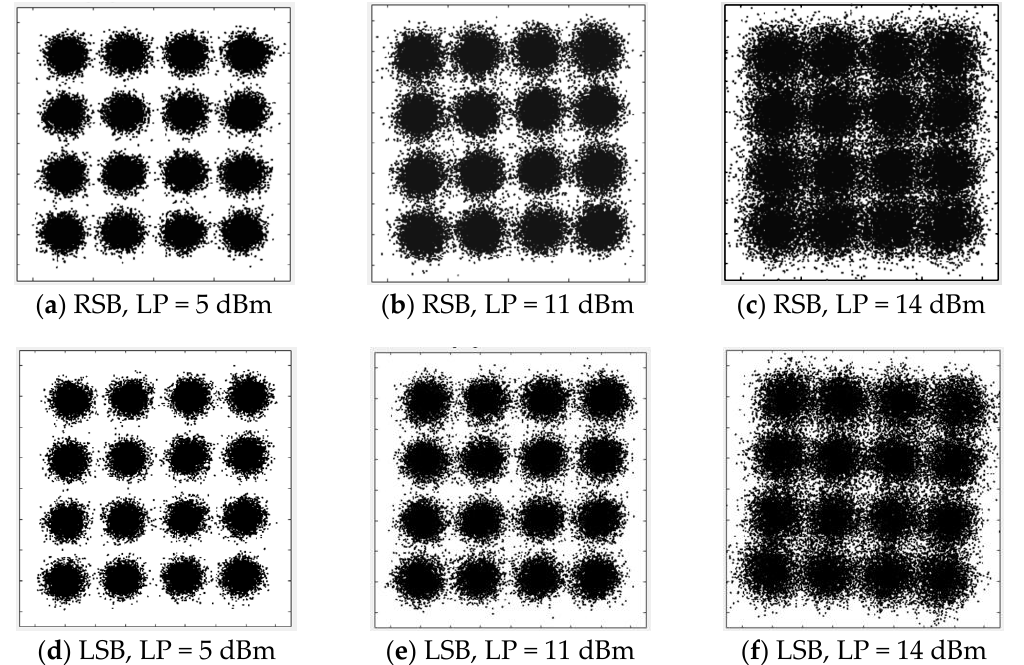
Figure 8. Constellation of 28 Gbaud QAM16 at 80 km SSMF transmission . ( a ) RSB, LP = 5 dBm; ( b ) RSB, LP = 11 dBm; ( c ) RSB, LP = 14 dBm; ( d ) LSB, LP = 5 dBm; ( e ) LSB, LP = 11 dBm; ( f ) LSB, LP = 14 dBm.